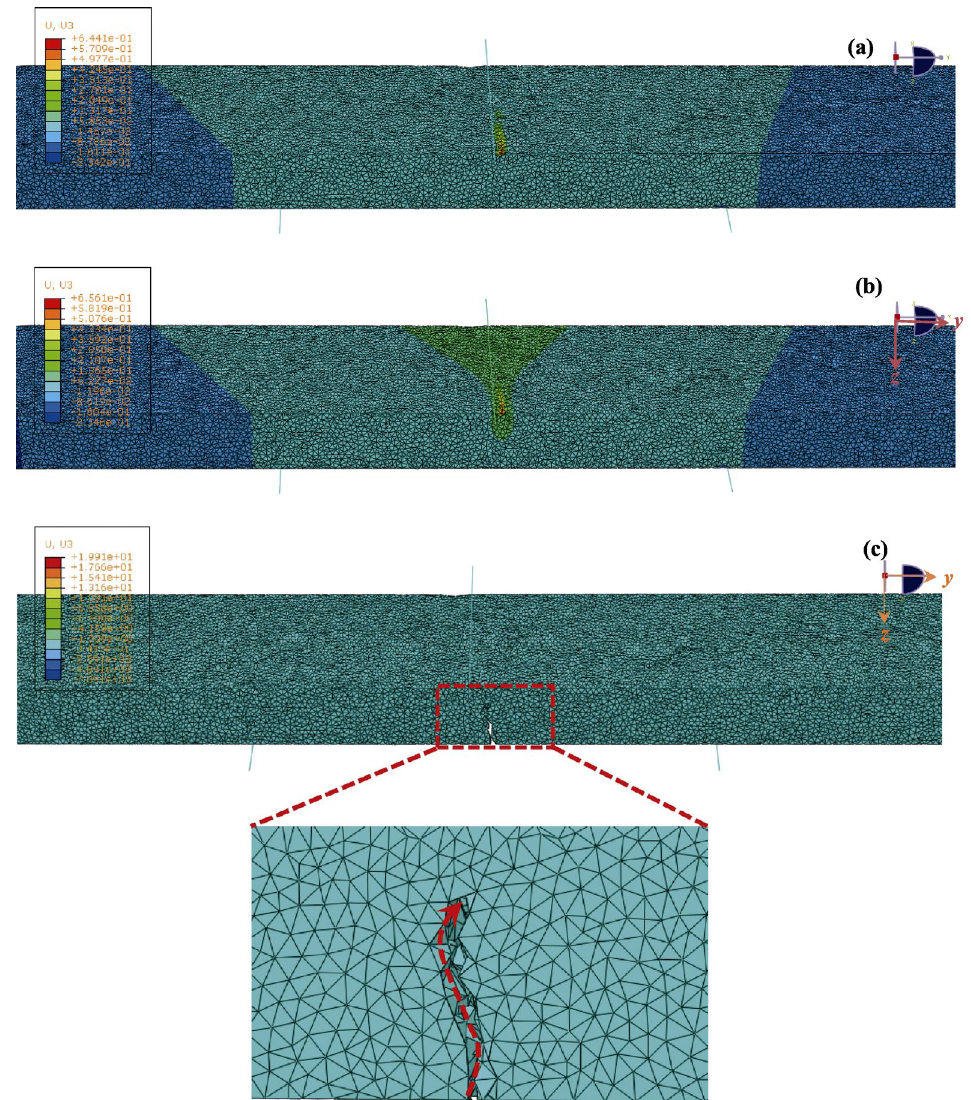
Fig. 8 Evolution of deflection of freestanding GYbZ coating during the FEM of three-point bending fracture process. The first fractured region is enlarged, as shown in inset.